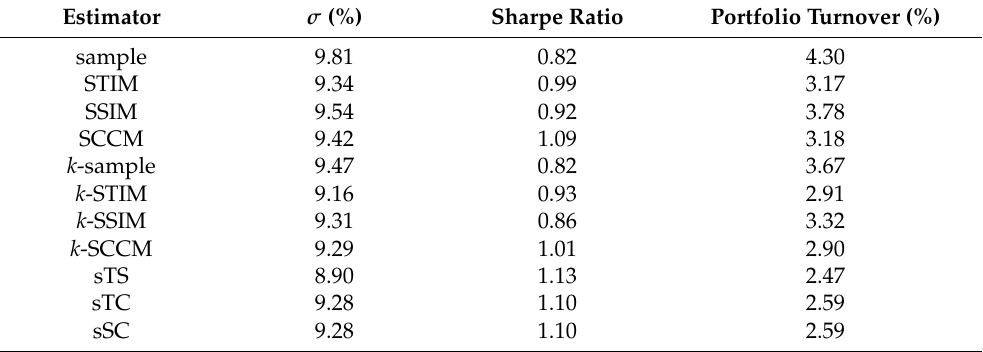
Table 3. Out-of-sample performance of eleven minimum variance portfolios with different covariance matrix estimations. Only top one hundred assets by market capitalization are considered, ( N = 100 ) . Estimator σ (%) Sharpe Ratio Portfolio Turnover (%) sample